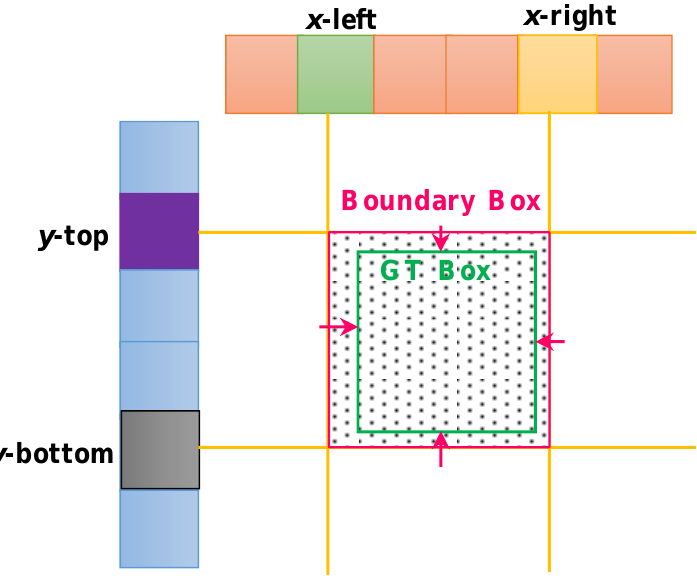
Figure 15. Implementation of the boundary regression fine localization (BRFL) used in BABP-Block.